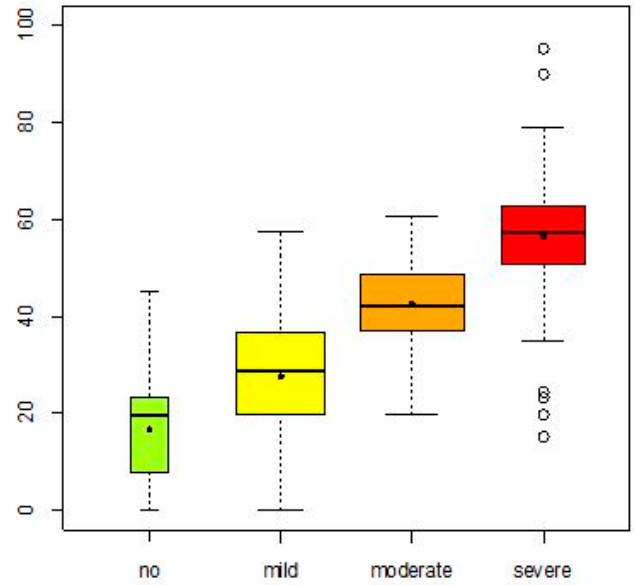
Figure 1. Boxplots showing the metric performance stratified by no, mild, moderate and severe level of difficulties in capacity. The y-axis represents the level of problems in performance in a metric scale raging from 0 (best performance) to 100 (worst performance); the x-axis represents the strata created based of severity of capacity difficulties.